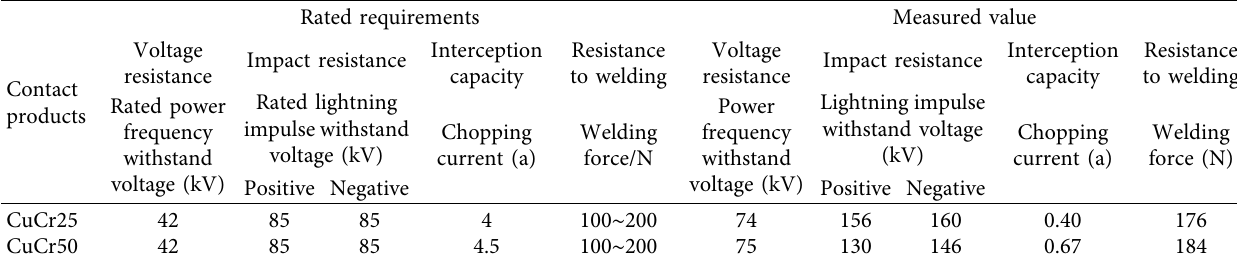
Table 4: Electrical performance test results of vacuum interrupters assembled with CuCr alloy [77].